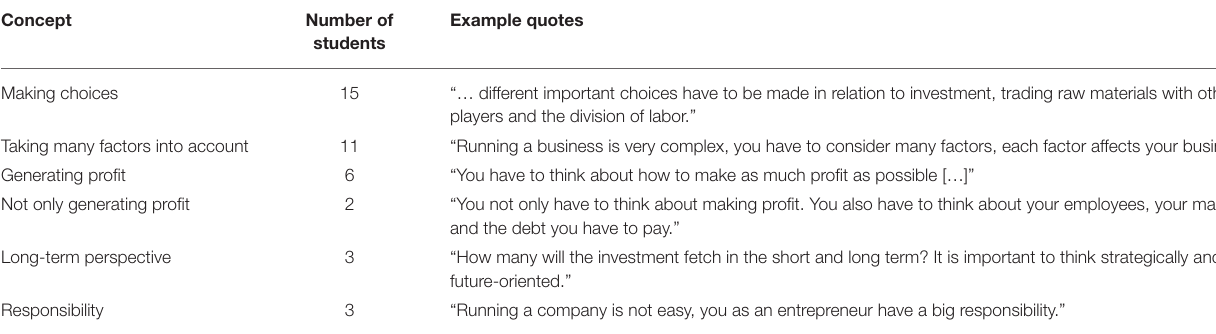
TABLE 7 | Concepts related to the role of an entrepreneur listed in the reflection report.